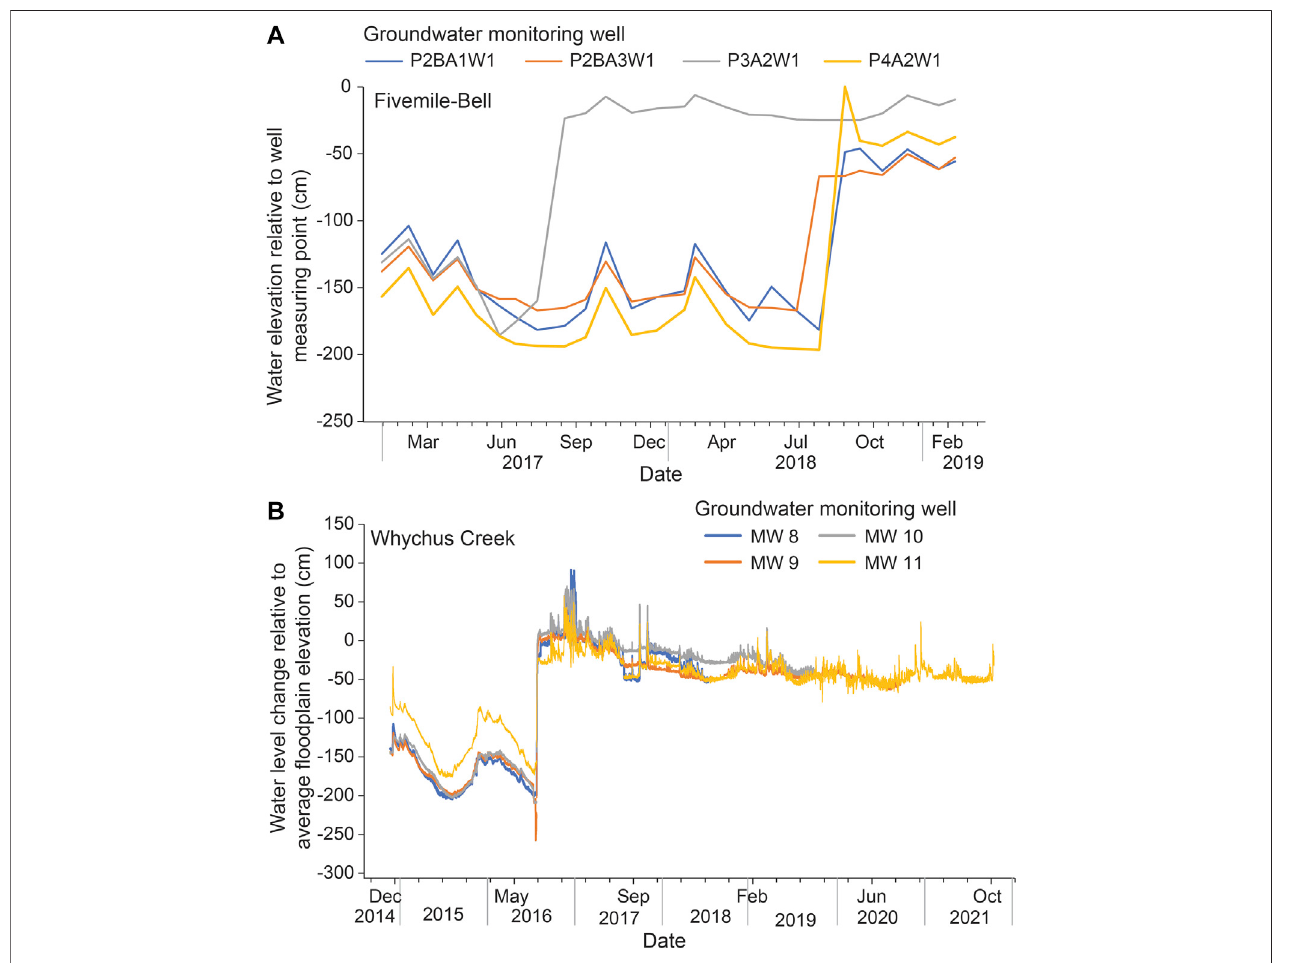
FIGURE 4 | Surface and water table depth at (A) Fivemile-Bell Creek; and (B) Whychus Canyon.